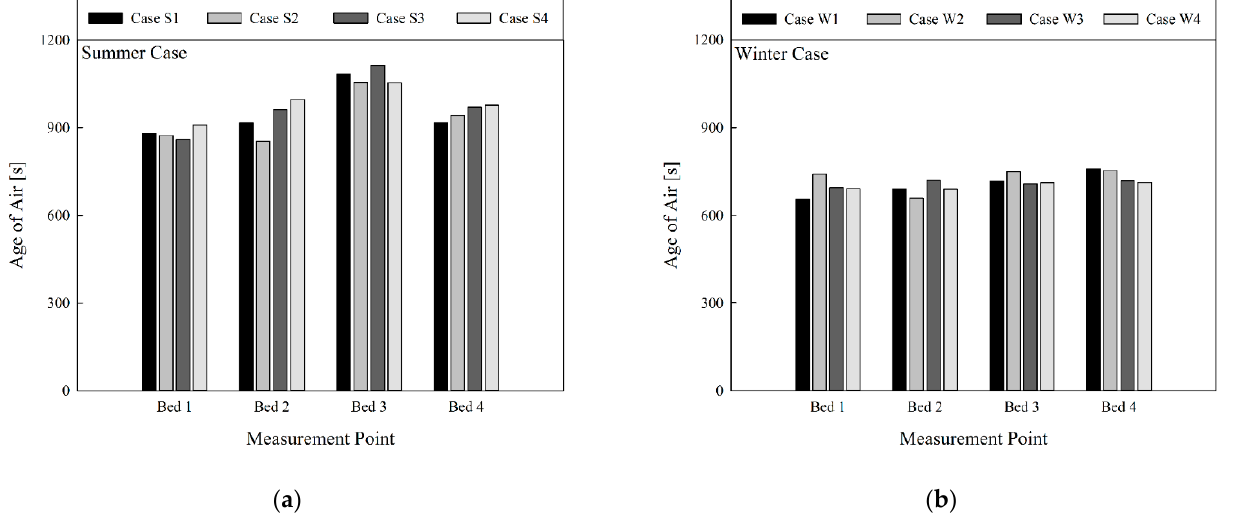
Figure 6. Comparison of age of air at bed location by season (in cases of ventilation system operation, four-way cassette fan coil unit operation, non-operation of air cleaner, no use of curtain): ( a ) summer; ( b ) winter.